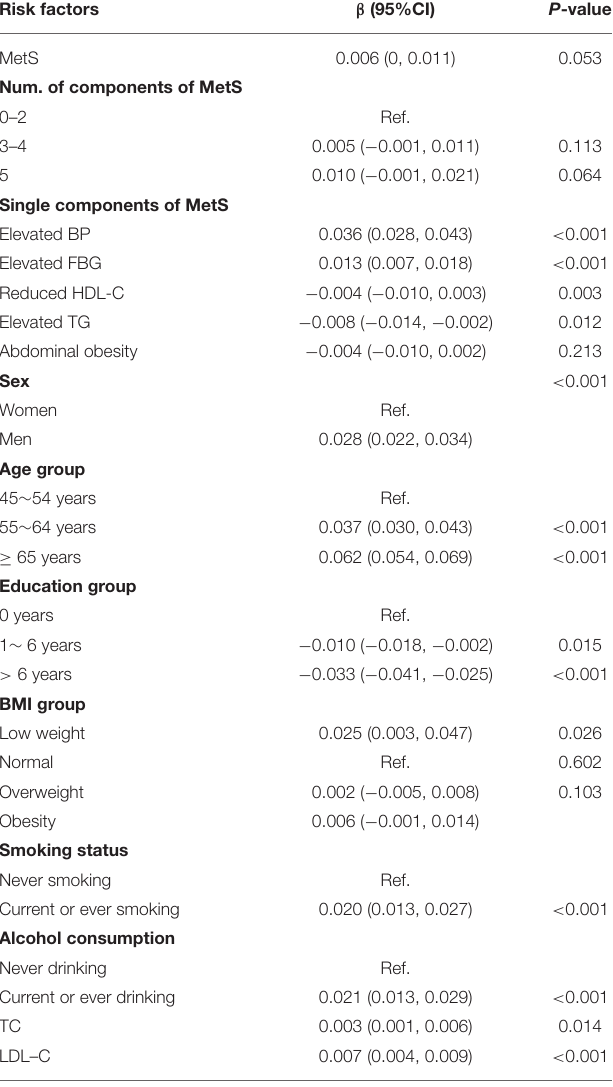
TABLE 3 | Relationship between MetS and CIMT in the univariate liner regression analysis.